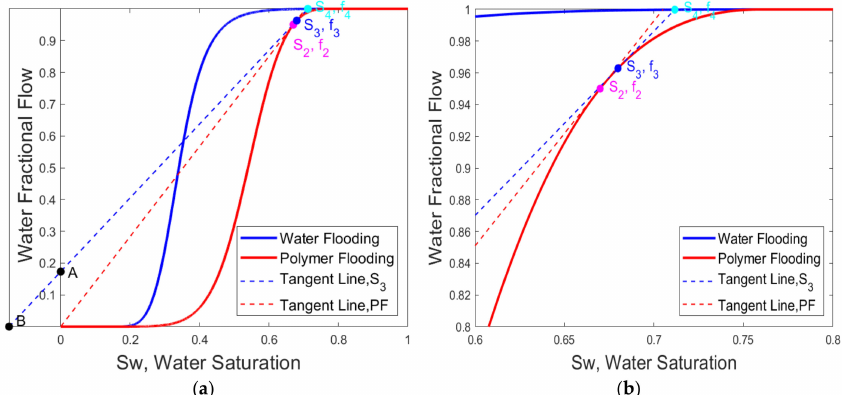
Figure 20. ( a ) Determination of the shock front during polymer slug injection; ( b ) Magnification of figure ( a ) for determining shock front location, t d , slug = 0.30 PV, t d , total = 1.74 PV.